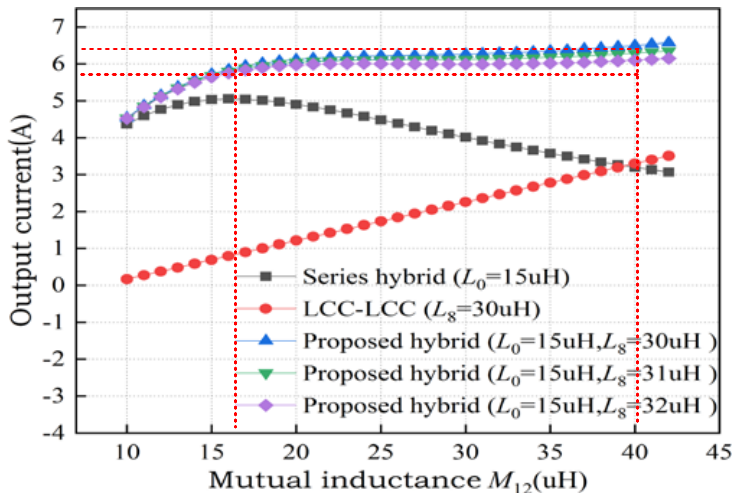
Figure 9. The function of I L and M 12 in Z -axis transmission distance.